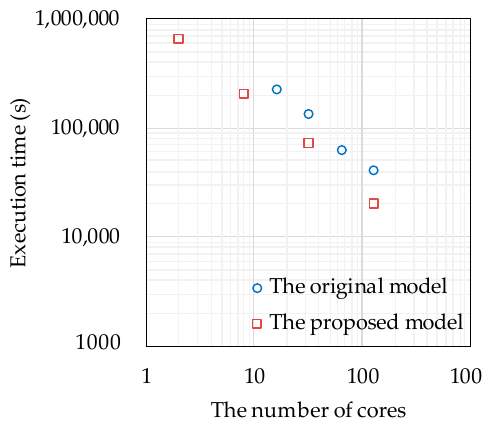
Figure 16. Execution time of the simulation with various numbers of cores. Blue points denote the time of the original model and red points denote the time of the proposed model.